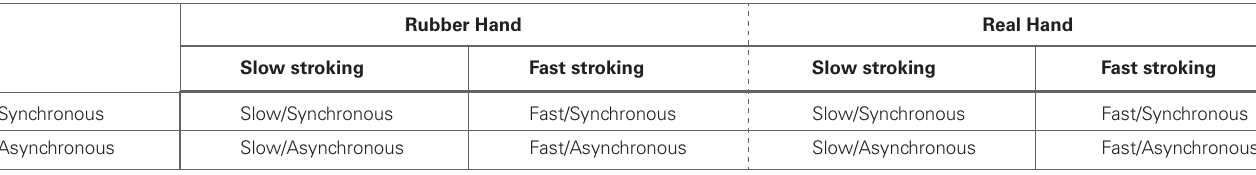
Table 1 | Table summarizing the experimental design.